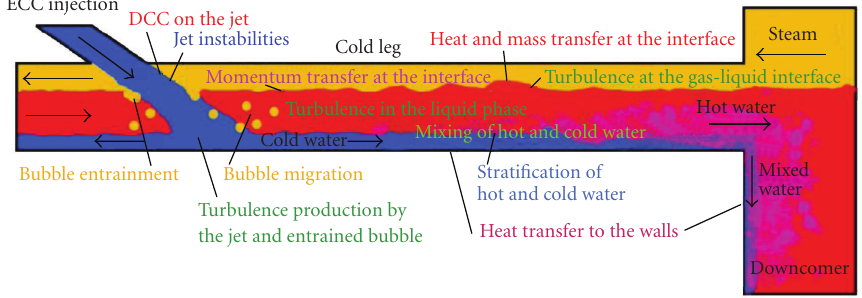
Figure 1: Most important flow phenomena during a PTS situation with partially filled cold